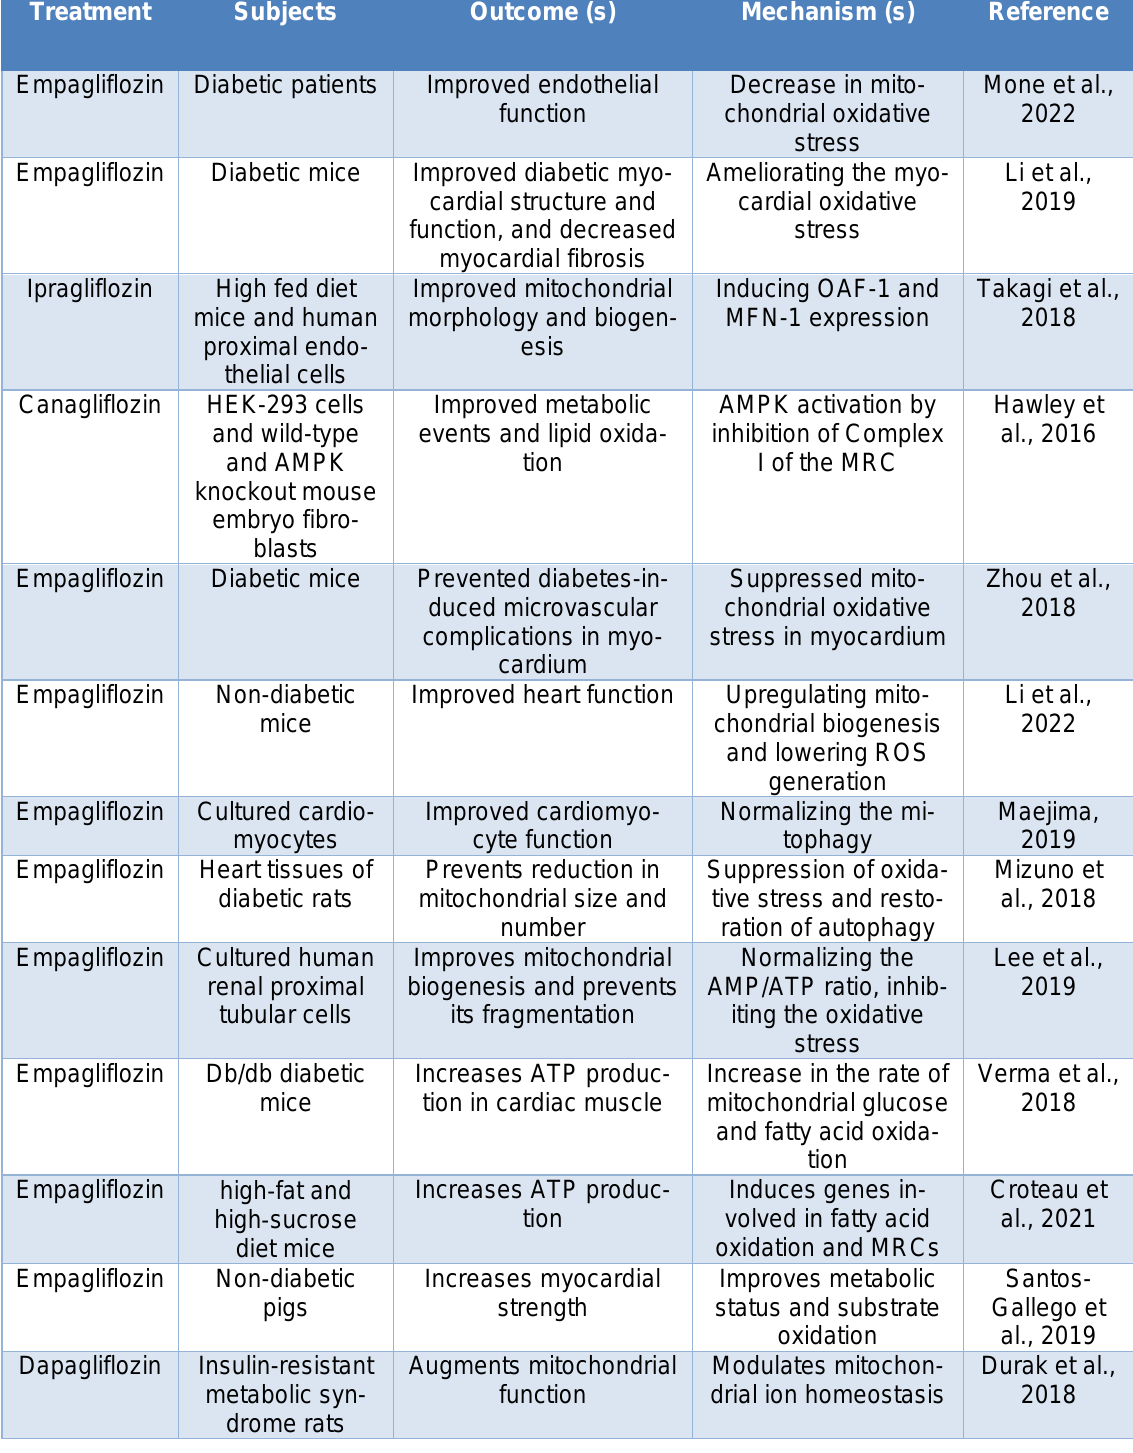
Table 1: Summary of the main in vitro and in vivo evidence concerning the effects of SGLT2 inhibitors on mitochondrial